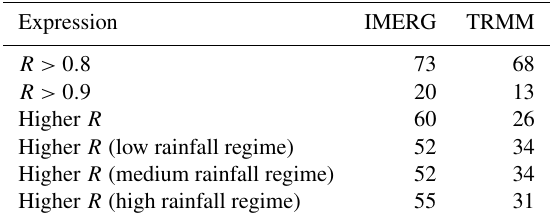
Table 5. Comparison of the IMERG and TRMM based on the num- ber of basins in which the satellite products show higher/lower cor- relation based on the year 2014 ( R = Pearson correlation coeffi-